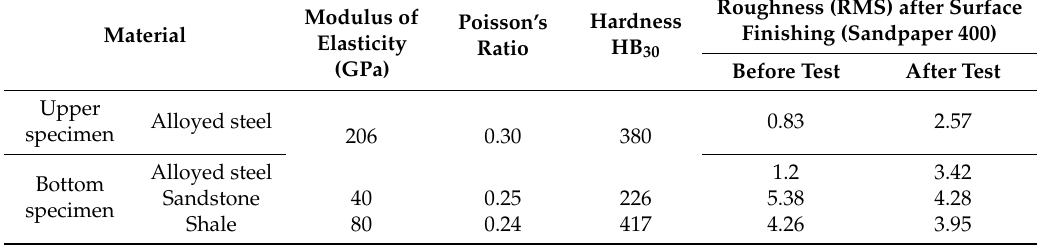
Figure 2. Specimens. ( a ) Alloyed steel; ( b ) sandstone; ( c ) shale.